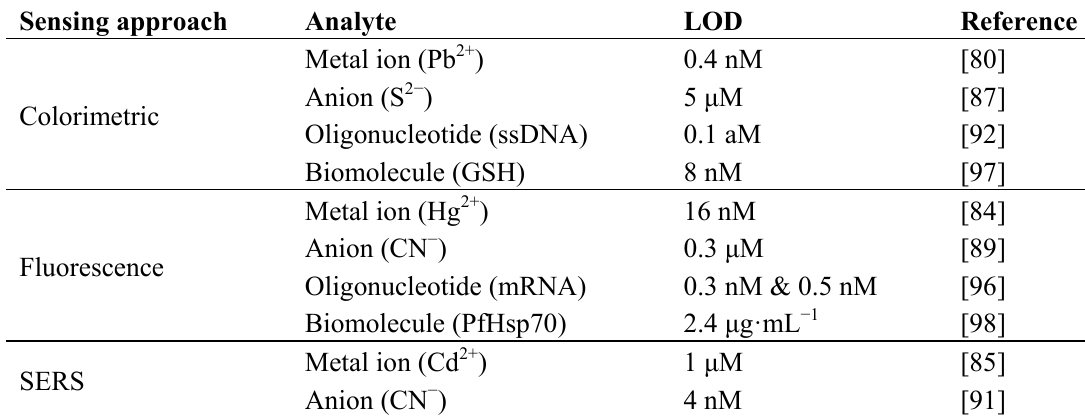
Table 5. Comparison of various GNP-based sensors.